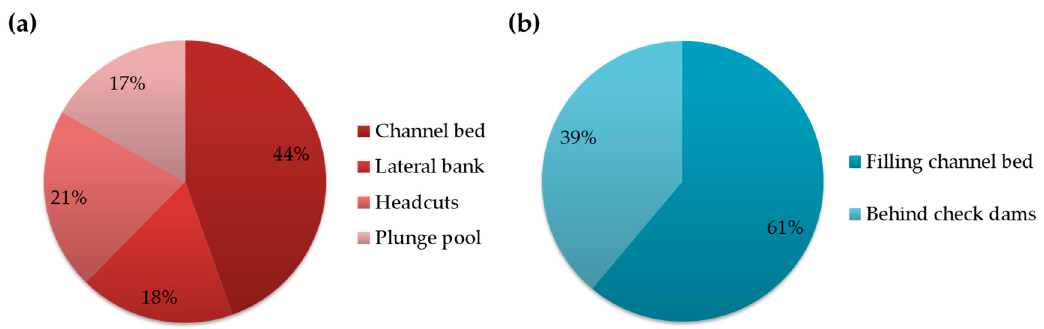
Figure 5. Percentage of the area covered by different erosional ( a ) and depositional features (only in the restored reach, i.e., the upper reach) ( b ).